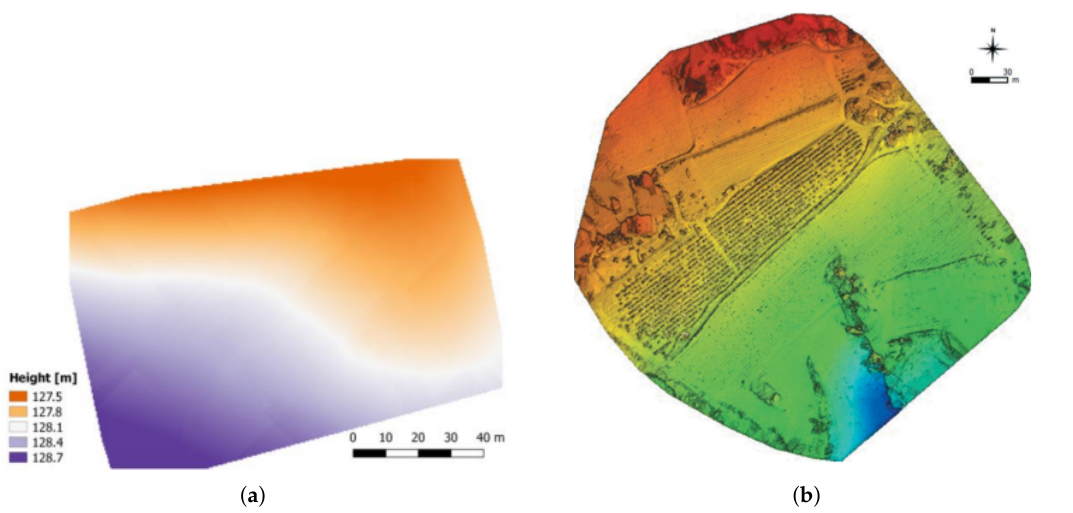
Figure 3. ( a ) A Digital Terrain Model [79]; and ( b ) a Digital Surface Model